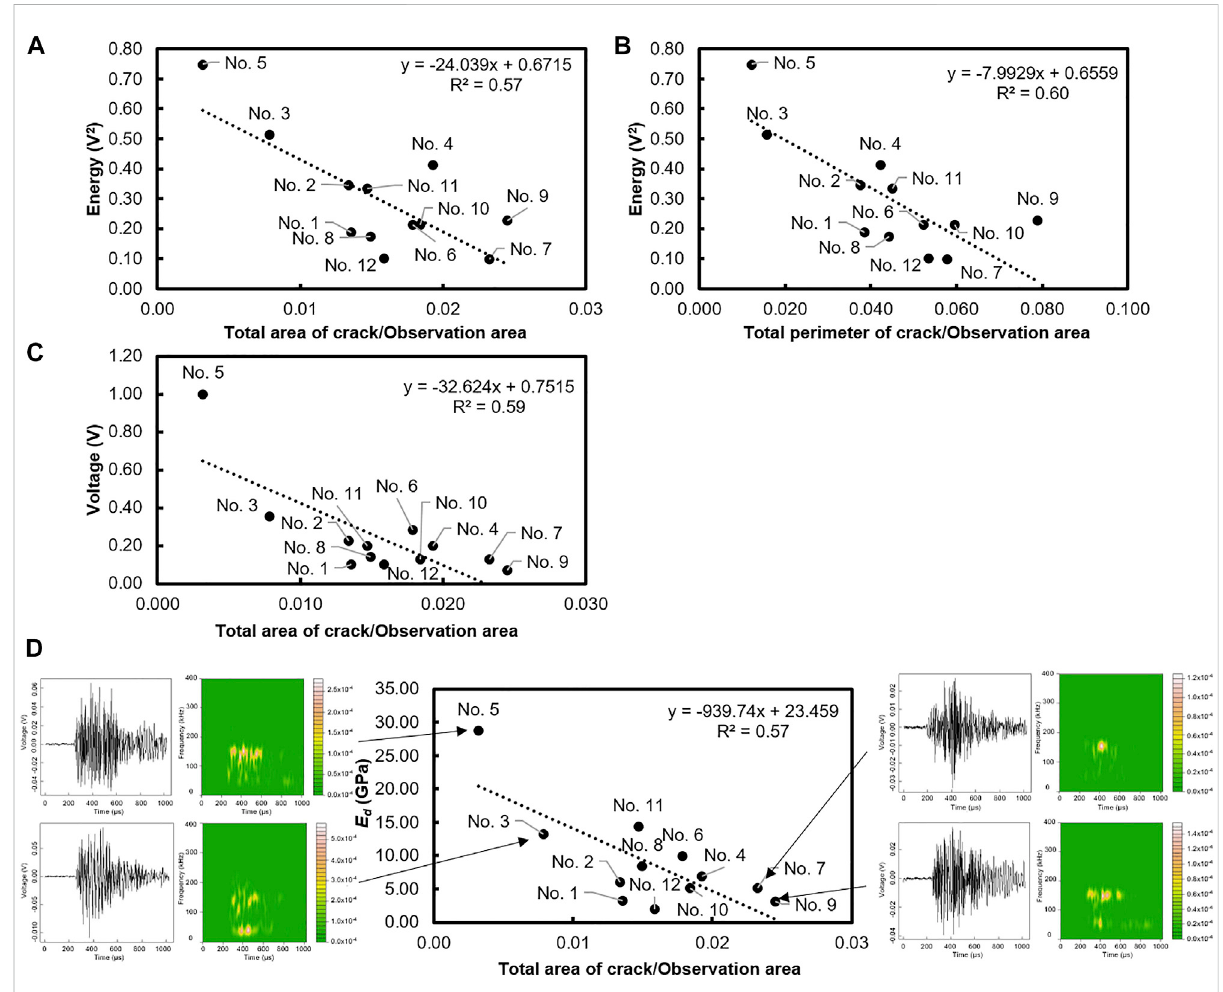
FIGURE 8 Relation between proportions parameters of concrete components and AU, NDT parameters. (A) Relation between energy and crack density. (B) Relationbetweenenergyandratioofthetotalperimeterofcracktotheobservationarearatio. (C) Relationbetweenvoltageandcrackdensity. (D) Relation between proportions parameters of concrete components and NDT